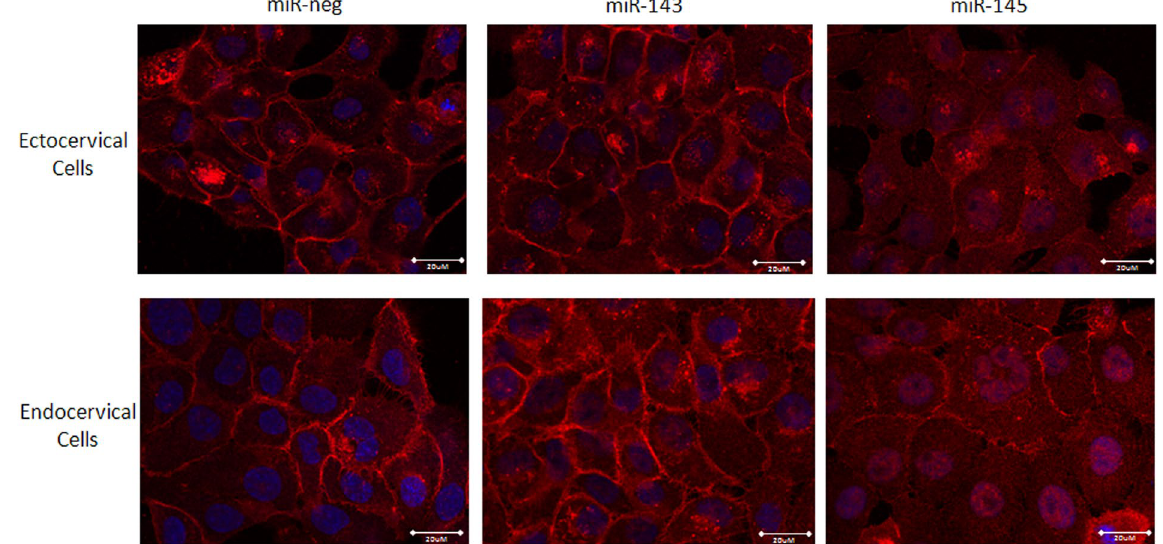
Figure 3. miR-145 inhibits JAM-A expression on the epithelial cell membrane of ectocervical and endocervical cells. Ectocervical and endocervical cells transfected to overexpress miR-143 and miR-145 were stained for JAM-A (red) and DAPI (cell nucleus, blue). JAM-A protein expression was reduced in both ectocervical and endocervical cells transfected with miR-145 but not miR-143 indicating that JAM-A is a direct target of miR- 145.